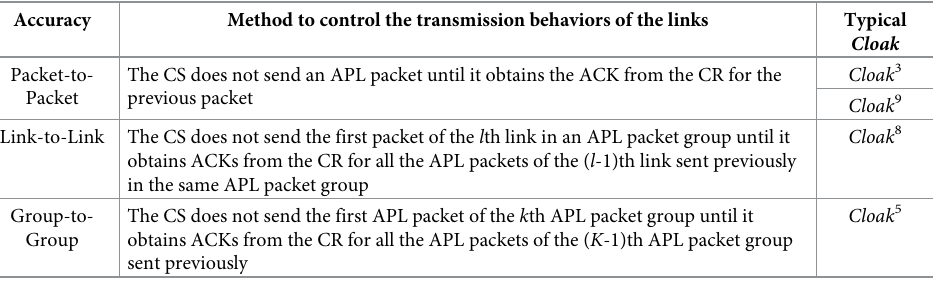
Table 1. Classification of Cloak synchronization schemes.